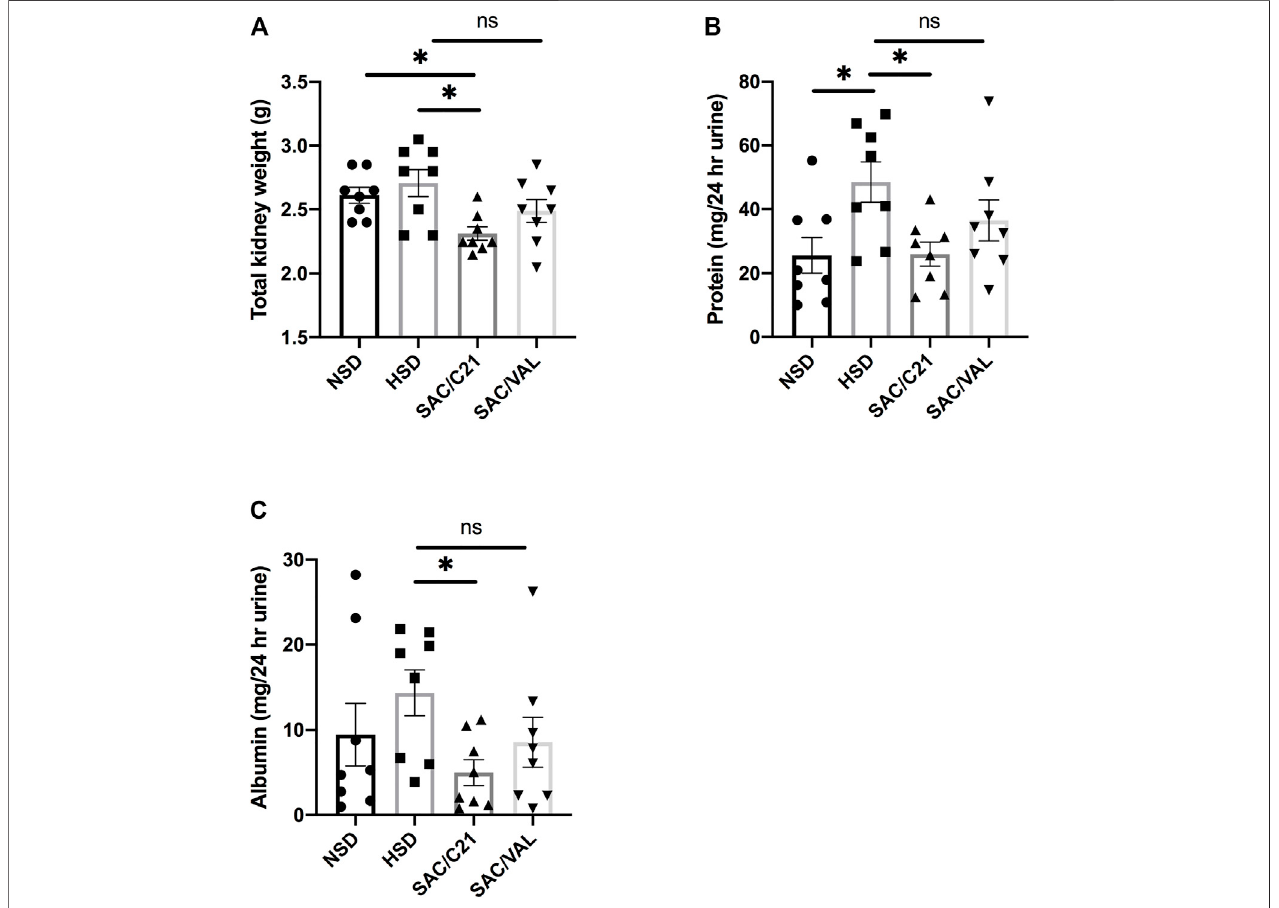
FIGURE1|(A) kidneyweight, (B) urinaryproteinnormalizedto24 hurinevolume, (C) urinaryalbuminnormalizedto24 hurinevolumeinobeseZuckerratsonNSD or HSD and treated with vehicle, SAC/C21, or SAC/VAL. Data shown as mean ± SEM, analyzed by one-way ANOVA, followed by Fisher ’ s LSD test. Results are considered signi fi cant at * p < 0.05, with a 95% con fi dence interval; n (cid:1) 8. NSD — normal salt diet fed + vehicle treated obese control, HSD — high salt diet fed + vehicle treatedobesecontrol,SAC/C21 — highsaltdietfedobeserattreatedwithsacubitril+C21,SAC/VAL —